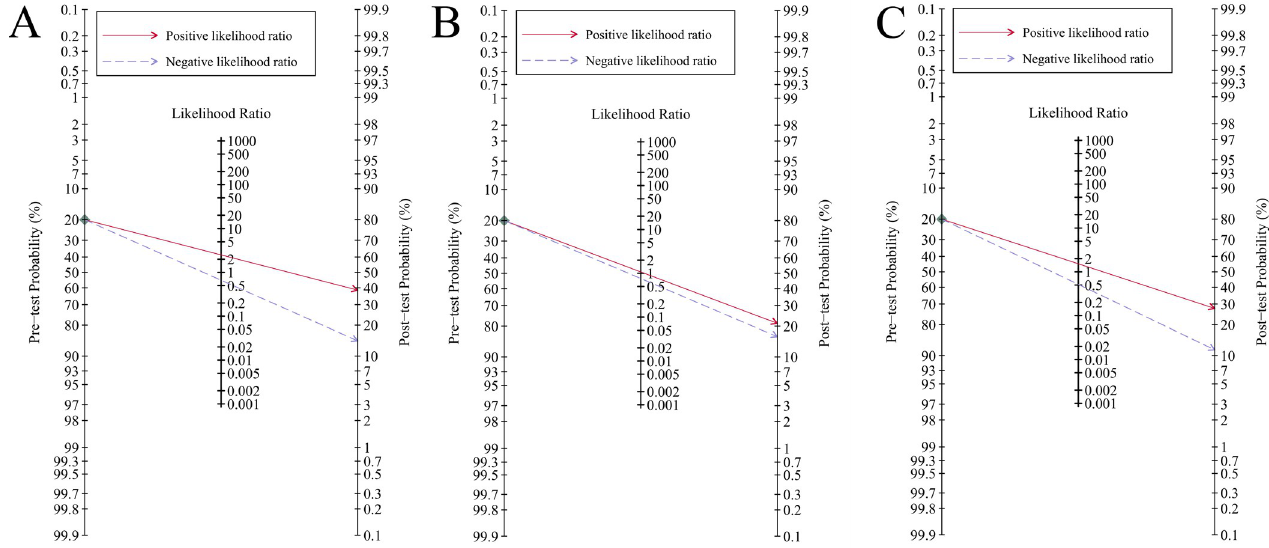
Fig 4. Fagan’ s nomogram for pre-test and post-test probability of mortality in patients with suspected sepsis. A: qSOFA; B: SIRS; C: NEWS.